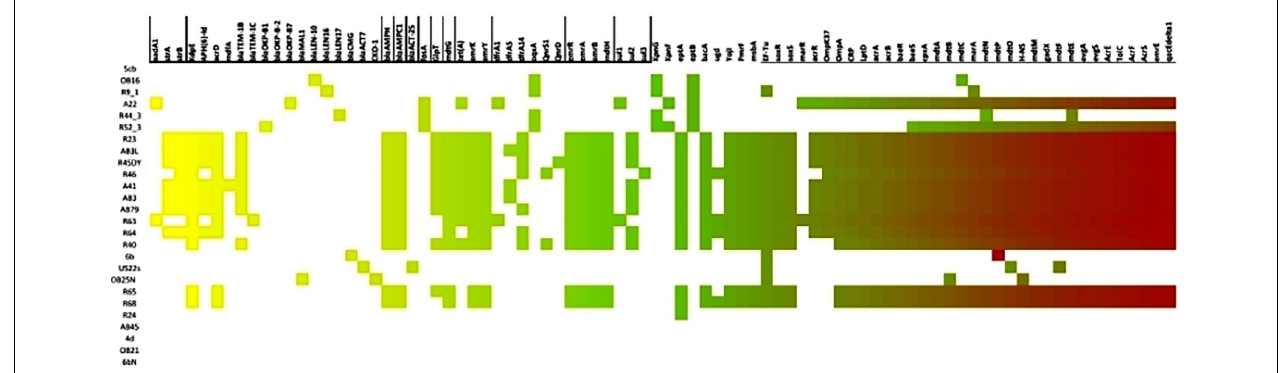
FIGURE 1 | Heat map showing the distribution of antimicrobial resistance genes among the recovered